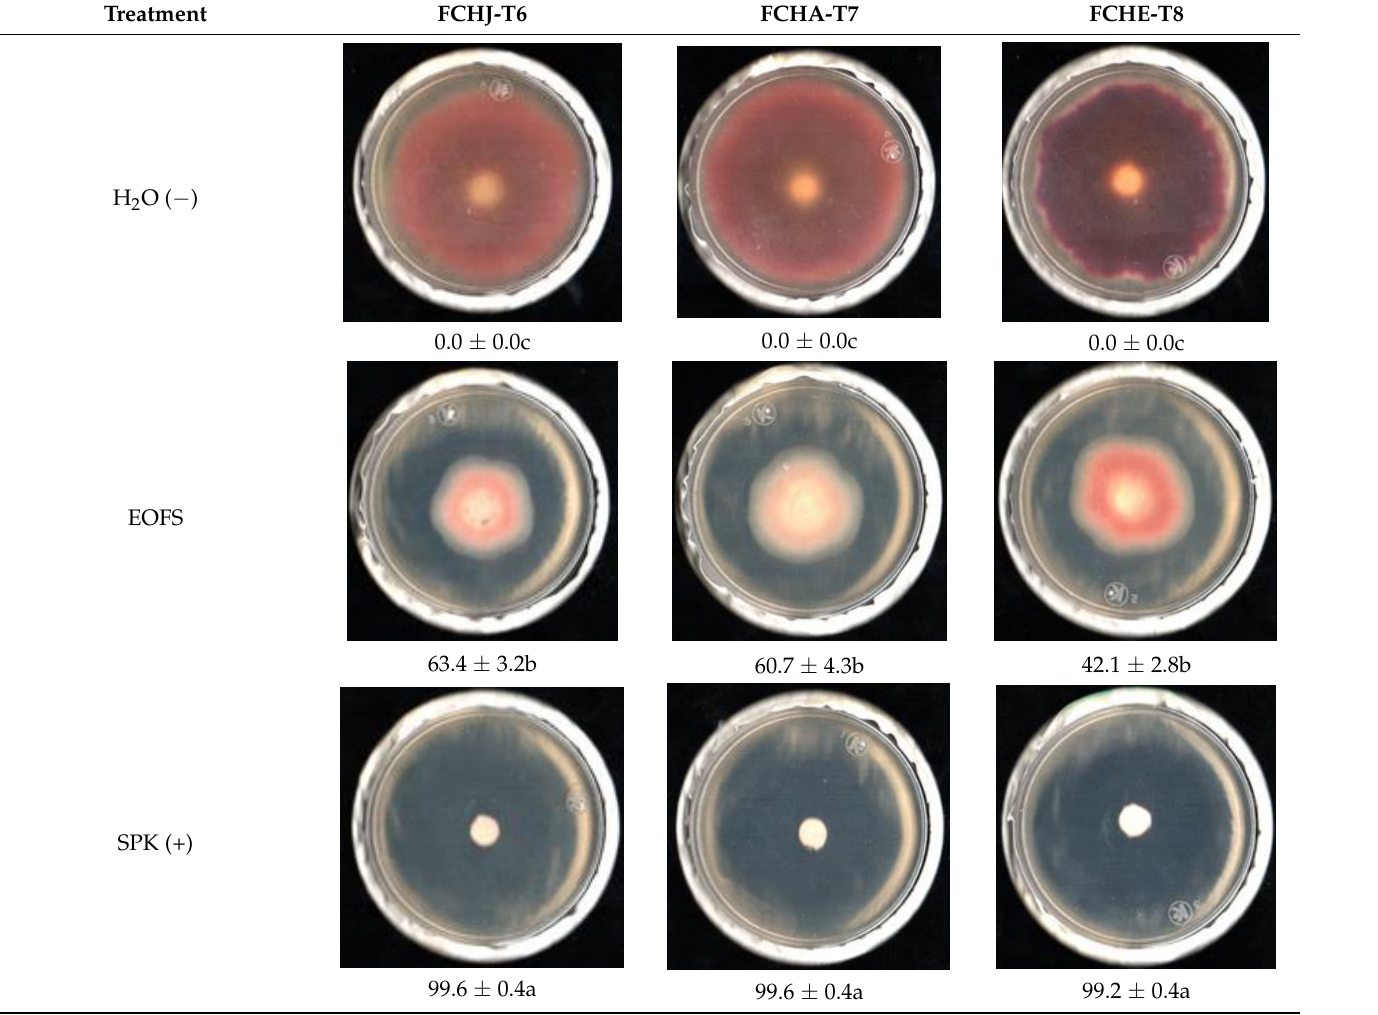
Table 4. Antifungal activity of the aerial part essential oil of P. auritum on F. oxysporum FCHA-T7 and FCHJ-T6 and F. equiseti FCHA-T8. Technique: mycelium disc microdiffusion.